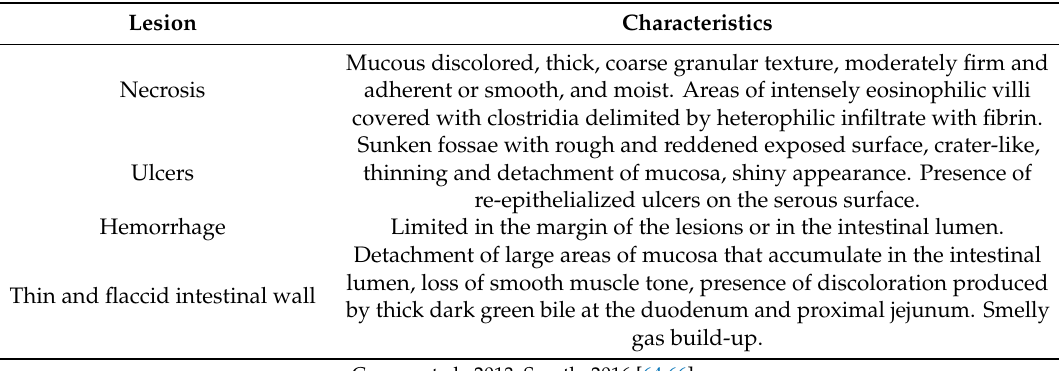
Table 3. Lesions found on histopathological examination. Lesion Characteristics Mucous discolored, thick, coarse granular texture, moderately firm and Necrosis adherent or smooth, and moist. Areas of intensely eosinophilic villi covered with clostridia delimited by heterophilic infiltrate with fibrin. Sunken fossae with rough and reddened exposed surface, crater-like, Ulcers thinning and detachment of mucosa, shiny appearance. Presence of re-epithelialized ulcers on the serous surface. Hemorrhage Limited in the margin of the lesions or in the intestinal lumen. Detachment of large areas of mucosa that accumulate in the intestinal lumen, loss of smooth muscle tone, presence of discoloration produced Thin and flaccid intestinal wall by thick dark green bile at the duodenum and proximal jejunum. Smelly gas